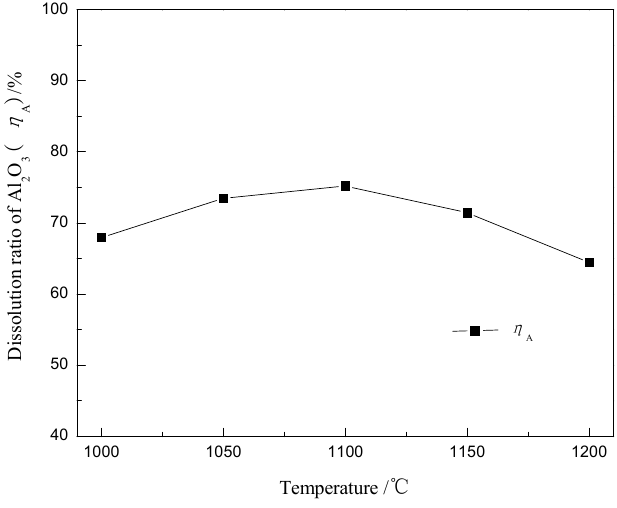
Figure 7. Plot between η A and temperature.